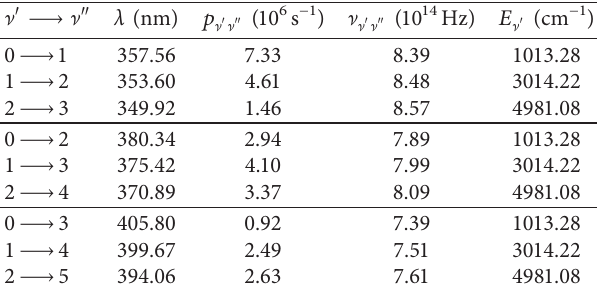
Table 1: Parameters of the SPS (N nitrogen molecules